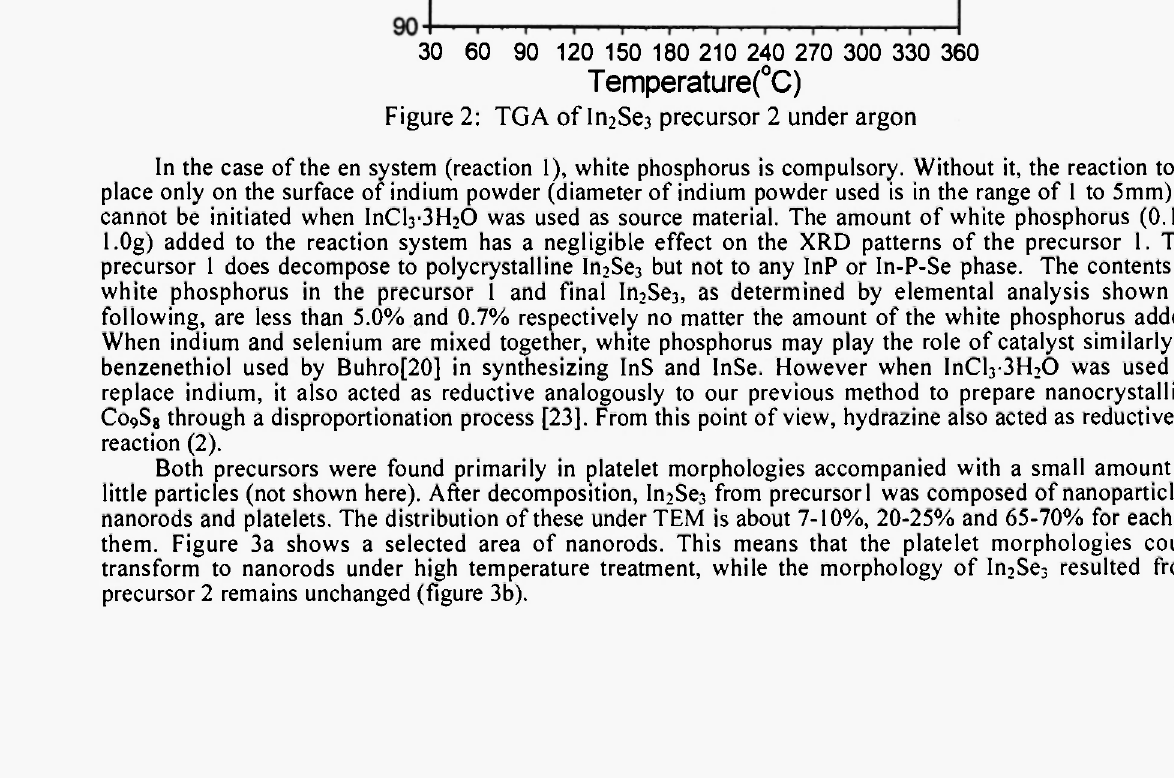
Figure 1: X-ray diffraction pattern (XRD) of: a) precursor 1 obtained in en system, b) precursor 2 obtained in hydrazine hydrate, and c) I^Sej decomposed from (a) and (b)